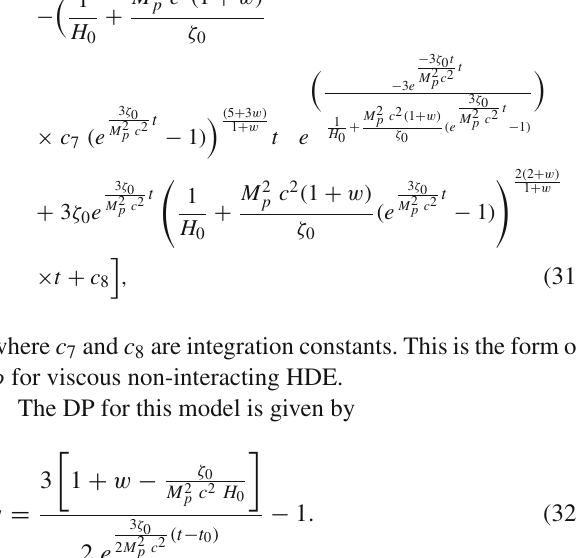
The expression of the statefinder parameter s can be obtained easily from the formula s = r − 1 using the values of q and 3 ( q − 1 2 ) r from Eqs. (32) and (33), respectively. We have plotted the r − s trajectories in Fig. 5a and the r − q trajectories in Fig. 5b. In Fig. 5a, the trajectories behave like quintessence for w > − 1; however, for w < − 1 the trajectories have higher positive value of r and negative value of s , and approach the (cid:3) CDM model at late times like the Chaplygin gas model. In Fig. 5b, we observe that all the trajectories show